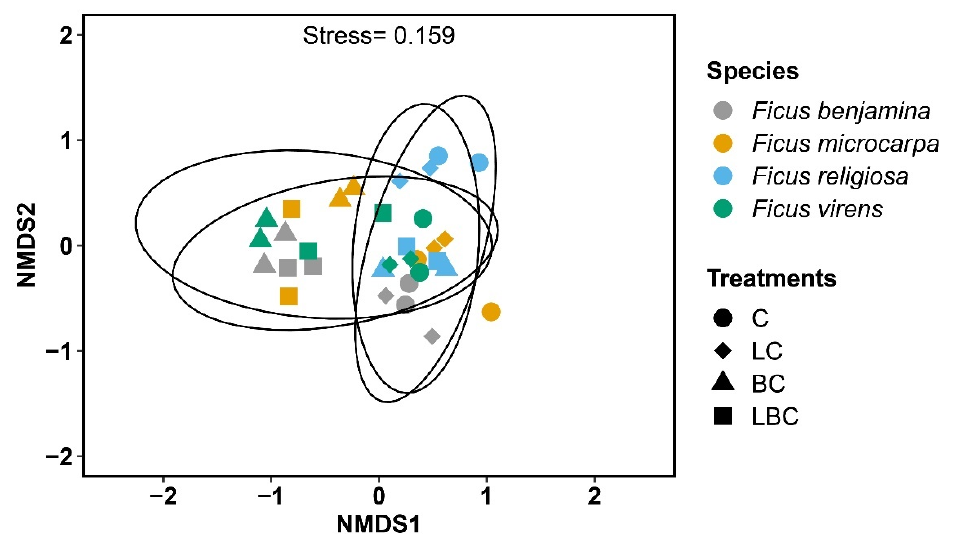
Figure 3. An non-metric multidimensional scaling (NMDS) ordination showing the BVOC compo- sitional differences among the samples with respect to the experimental treatments and the four Ficus species. Each oval represents the 95% confidence interval from the centroid. C = control, LC= leaf-cutting, BC = branch-cutting, and LBC = leaf-branch-cutting.